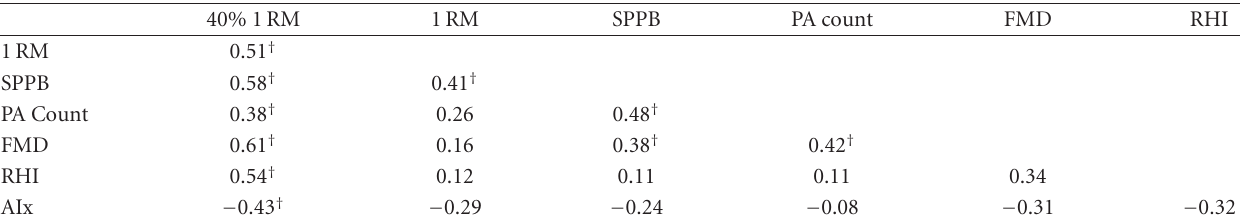
Table 3: Correlation matrix for measures of vascular function and muscle function adjusted for potential confounders ∗